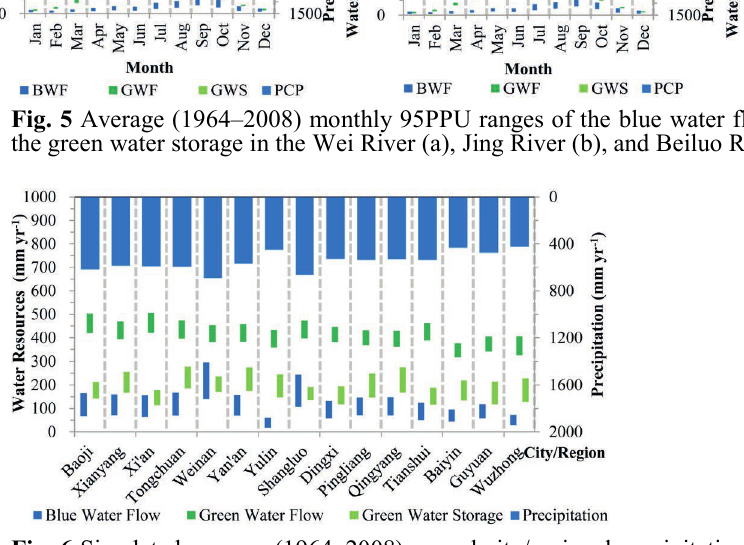
Fig. 6 Simulated average (1964–2008) annual city/regional precipitation, blue water flow, green water flow and green water storage at 95% prediction